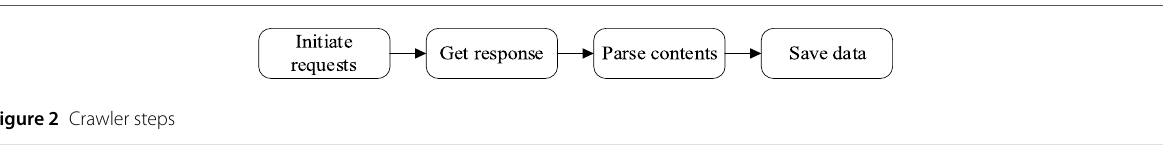
represents the set of all word-based nodes in the graph, and E represents the set of connected edges between points in the graph. The scoring of nodes V i is shown